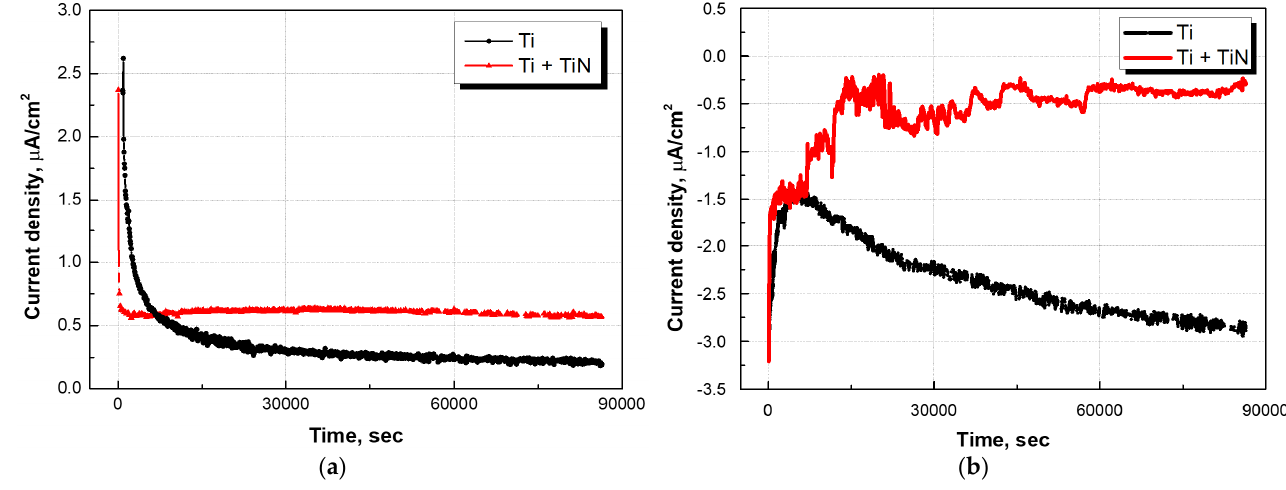
Figure 5. I–t curves after potentiostatic experiment of titanium substrate and TiN-coated specimen in simulated PEMFC environment. ( a ) Cathode (air bubbling); ( b ) Anode (H 2 bubbling).